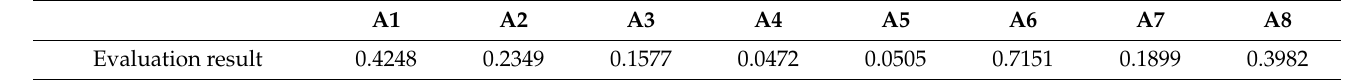
Table 11. Regulatory risk utility function of market-oriented businesses based on BBWM-TOPSIS model. A1 A2 A3 Evaluation